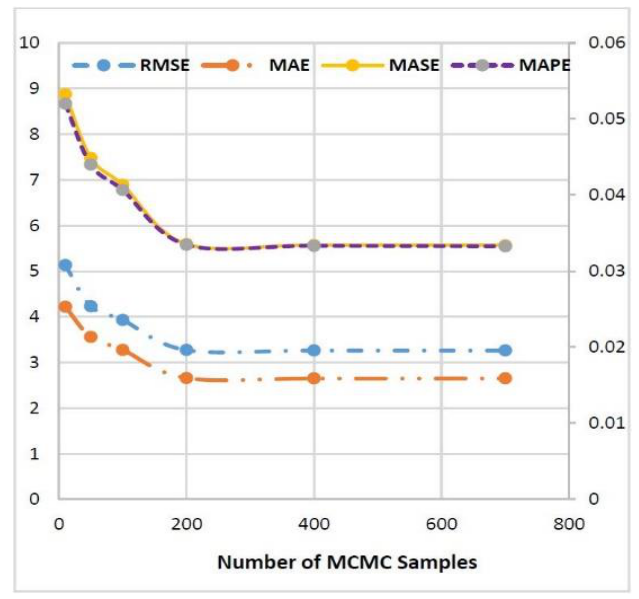
Figure 9. Effect of the Bayesian inference on the performance metrics.